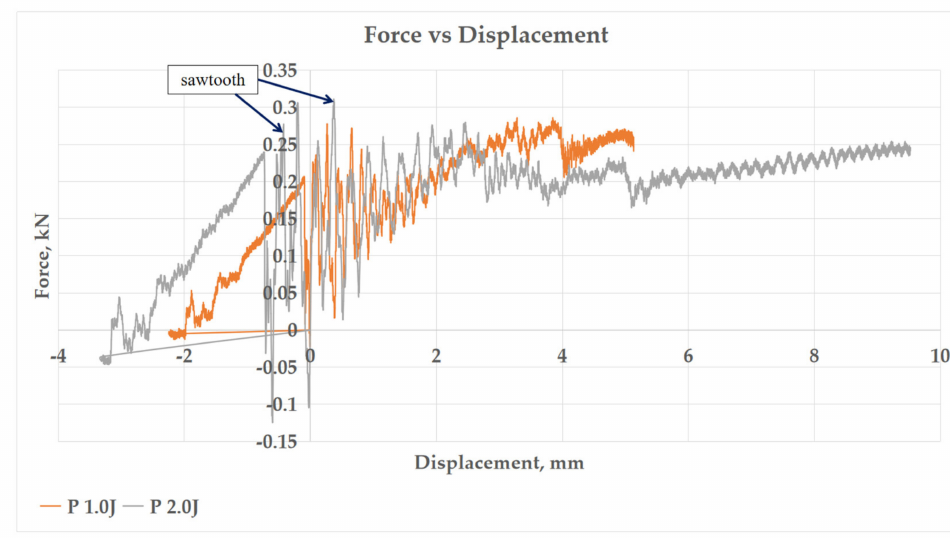
Figure 8. Force–Displacement curve of impact energy prior to P perforation.